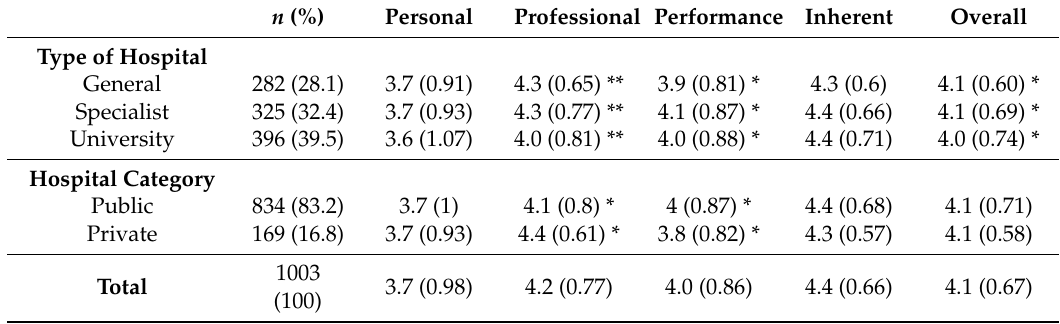
Table 2. Career satisfaction of physicians in Poland by type of hospital and hospital category ( n = 1.003). n